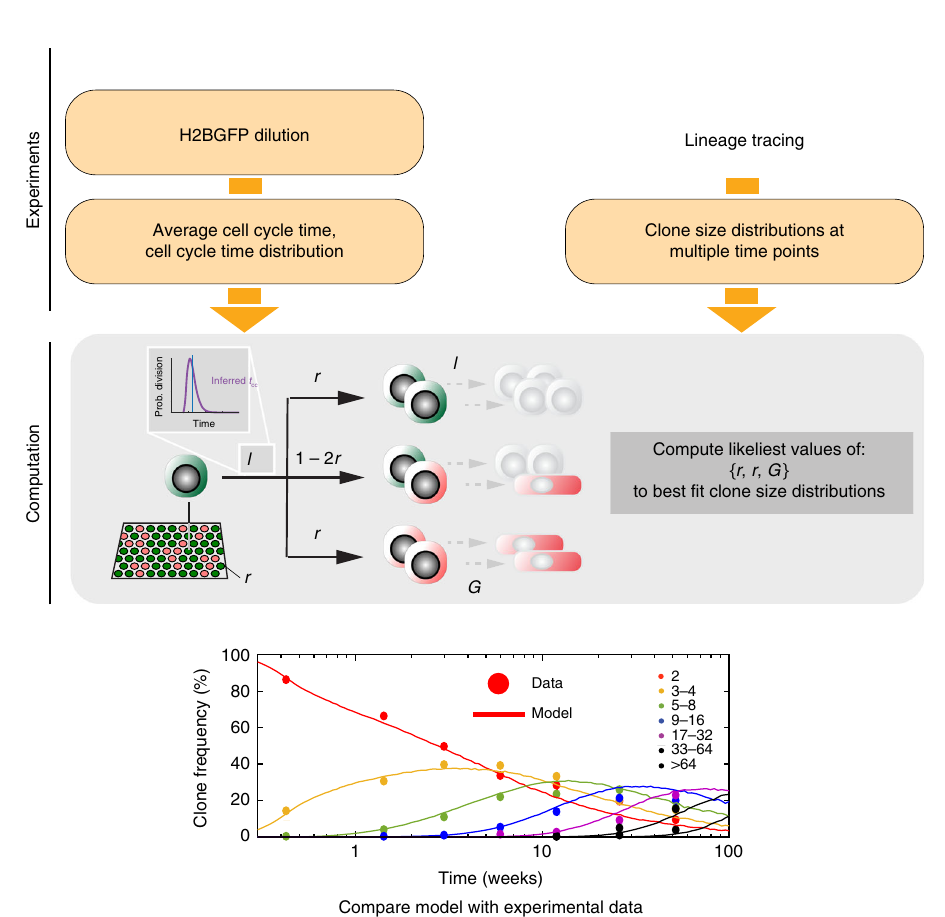
Compare model with experimental data Fig. 6 Method for single-progenitor model testing and parameter inference. Method to single-progenitor model testing and infer model parameters. Orange boxes indicate experiments and resulting data, gray box computational model and parameter estimation. Italics indicate parameters in the SP model. The multimodality testing of H2B-GFP data showed that there is a single population dividing at the same average rate in epidermis and esophagus, consistent with the SP model (Fig. 3d). To test the SP model, the average cell-cycle time ( λ ) and cell-cycle time distribution were inferred from H2B-GFP experiments. These values are used in computational analysis to estimate the values of the other parameters in the SP model, the proportion of progenitor cells in the basal layer ρ , the proportion of symmetric cell division outcomes r , and the strati fi cation rate of differentiating cells leaving the basal cell layer ( Γ ). Multiple sets of values for the unknown parameters were tested. For each set of unknown parameter values 100,000 progenitor-derived clones were simulated (lines) and inferred clone-size distributions compared with experimental ones (points) obtained from lineage tracing. The likeliest sets of parameter values were obtained by maximum likelihood estimation for each linage tracing data set. The quality of the fi t was assessed by determining whether the simulated values lie within the 95% con fi dence interval of the experimental clone-size measurements at each time The improved resolution of parameter estimates identi fi es cells cycle comparatively slower in the epidermis, on average differences in cell division rates across the epidermis and the between 3.5 and 6 days depending on body site 35 . However, our study suggests individual cell-cycle periods are tightly con- esophagus (Table 1). Proliferating cells divide rapidly in the trolled, showing little variation around average division rate, esophageal epithelium, on average every ~2.4 days (similar to per territory. keratinocyte turnover rate in oral mucosa), while progenitor